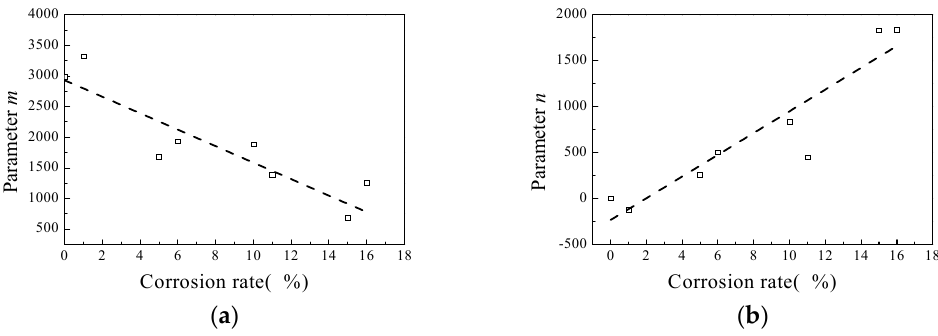
Figure 8. Parameter variation with the corrosion rate. ( a ) m variation with corrosion rate, ( b ) n variation with corrosion rate